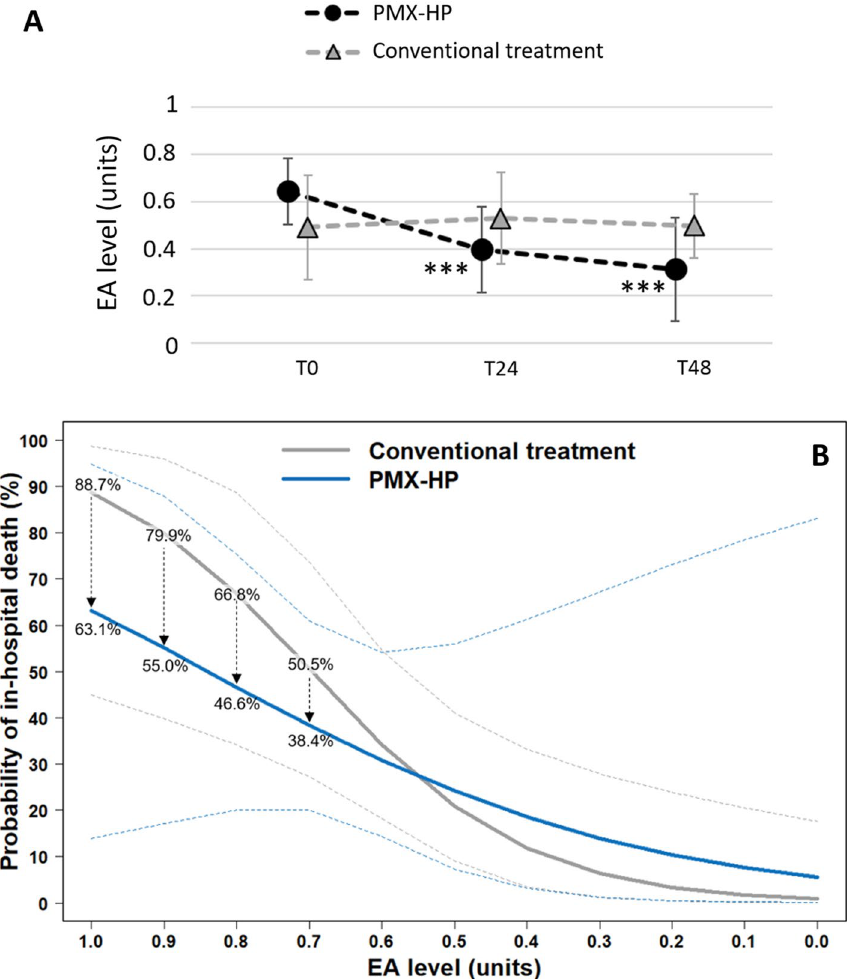
Figure 1. ( A ) Changes of mean (± SD) endotoxin activity levels with (black) and without (gray) PMX-HP treatment. ( B ) Probability of in-hospital death according to EA level at T0 categorized by treatment strategy. Dashed lines enclose the 95% CI. * p < 0.05 vs. baseline (T0); ** p < 0.01 vs. baseline (T0); *** p < 0.001 vs. baseline (T0). EA endotoxin activity, PMX-HP polymyxin B-hemoperfusion, SD standard